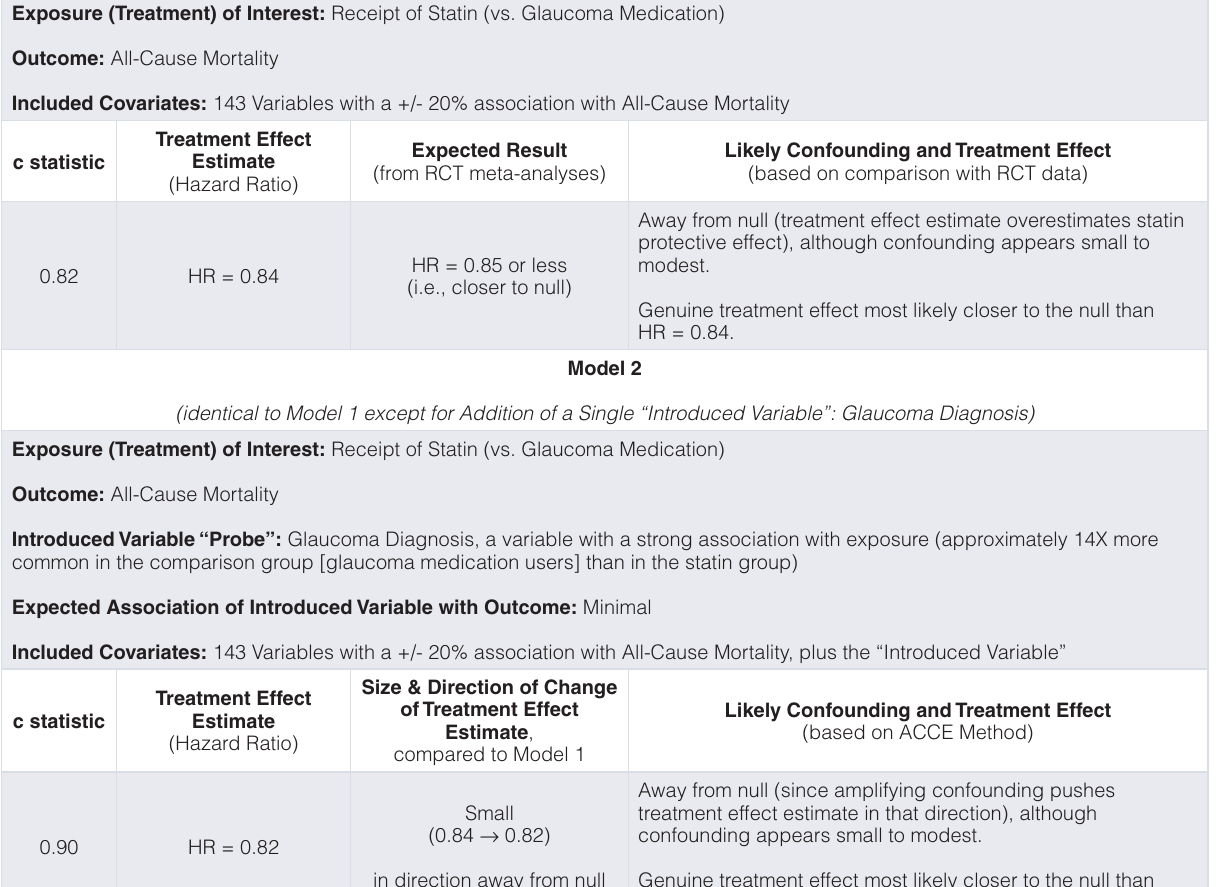
Table 1A. Statin - mortality analysis Model